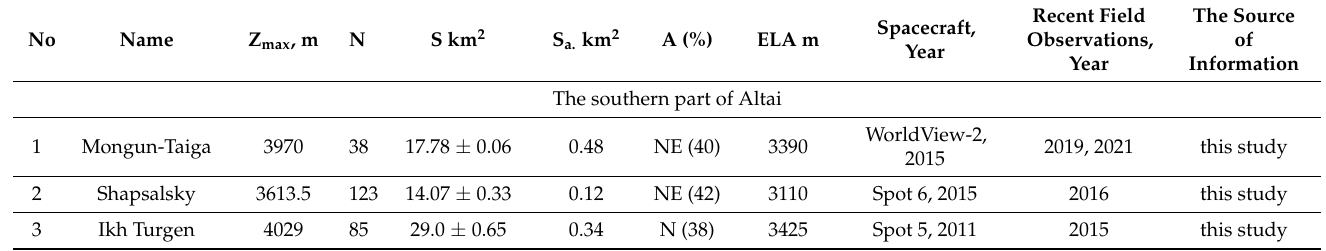
Table 4. Recent glaciation of Altai mountains. Z max —maximal altitude of the mountain ridge, N—the number of the glaciers, S—The area of the glaciers (km 2 ), S a —the average area of